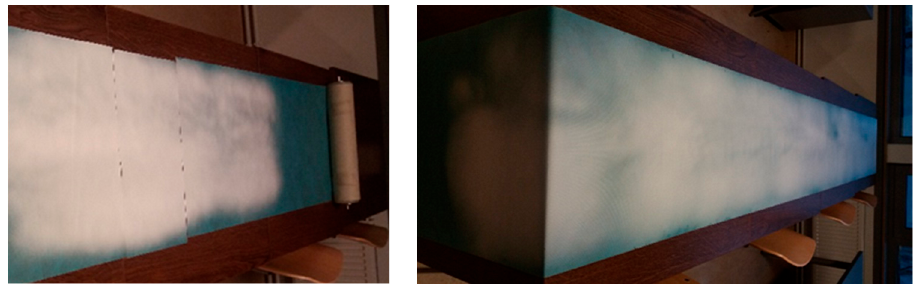
Figure 5. Result obtained after spinning on the support material for 1 h at a speed of 0.003 m/s using a cylinder-type electrode: sample 10PVA130 (left) and 8PVA130 (right). a cylinder-type electrode: sample 10PVA130 ( left ) and 8PVA130 ( right